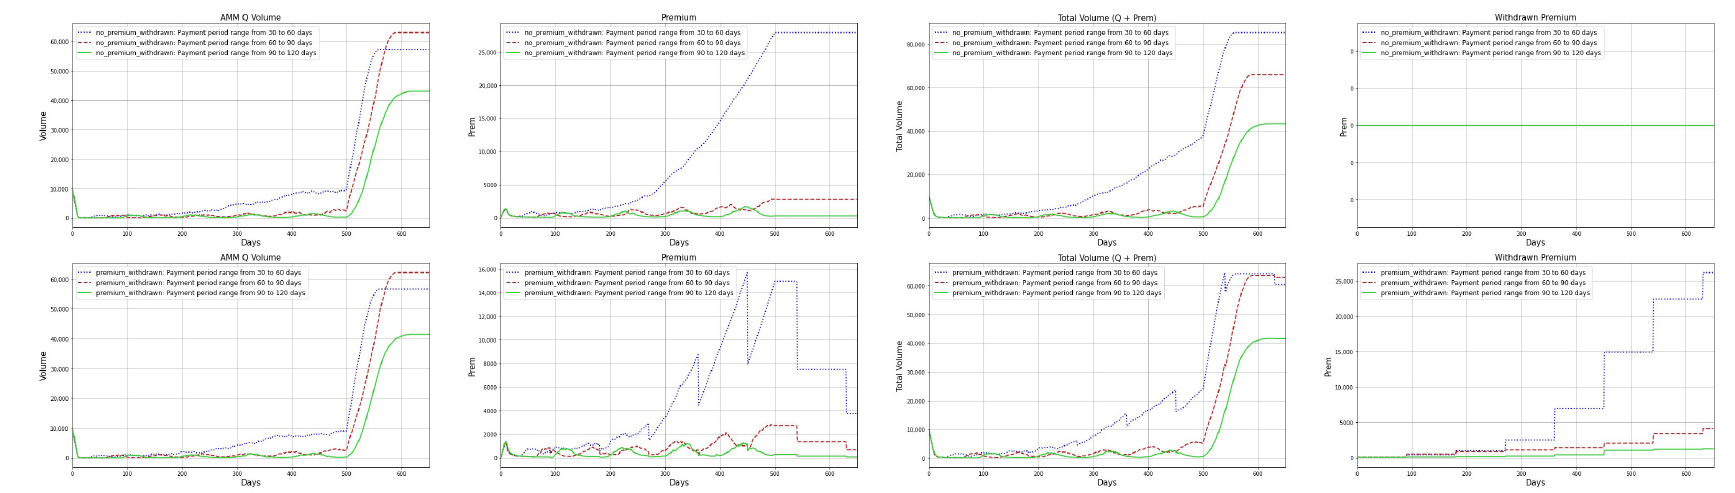
Figure A9. rkAMM Curves from simulation of scenario 3 and 90 days of withdrawal period.